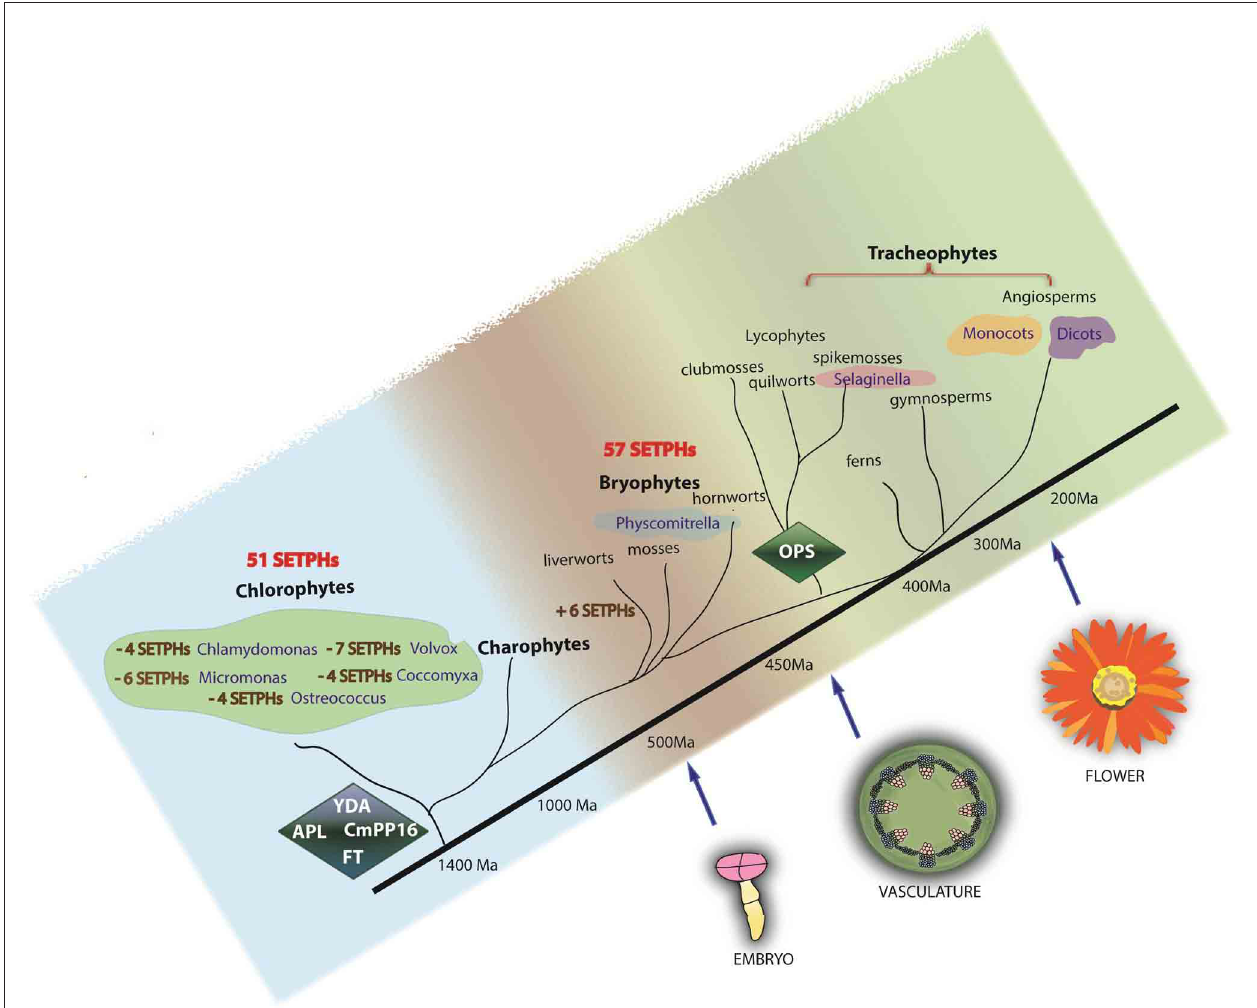
FIGURE 5 | Phylogeny of SETPHs in plants. Presence of SETPHs are shown in each taxa. Minus signs refer to absence of orthologs in chlorophytes. YDA , CmPP16 , FT and APL are present in